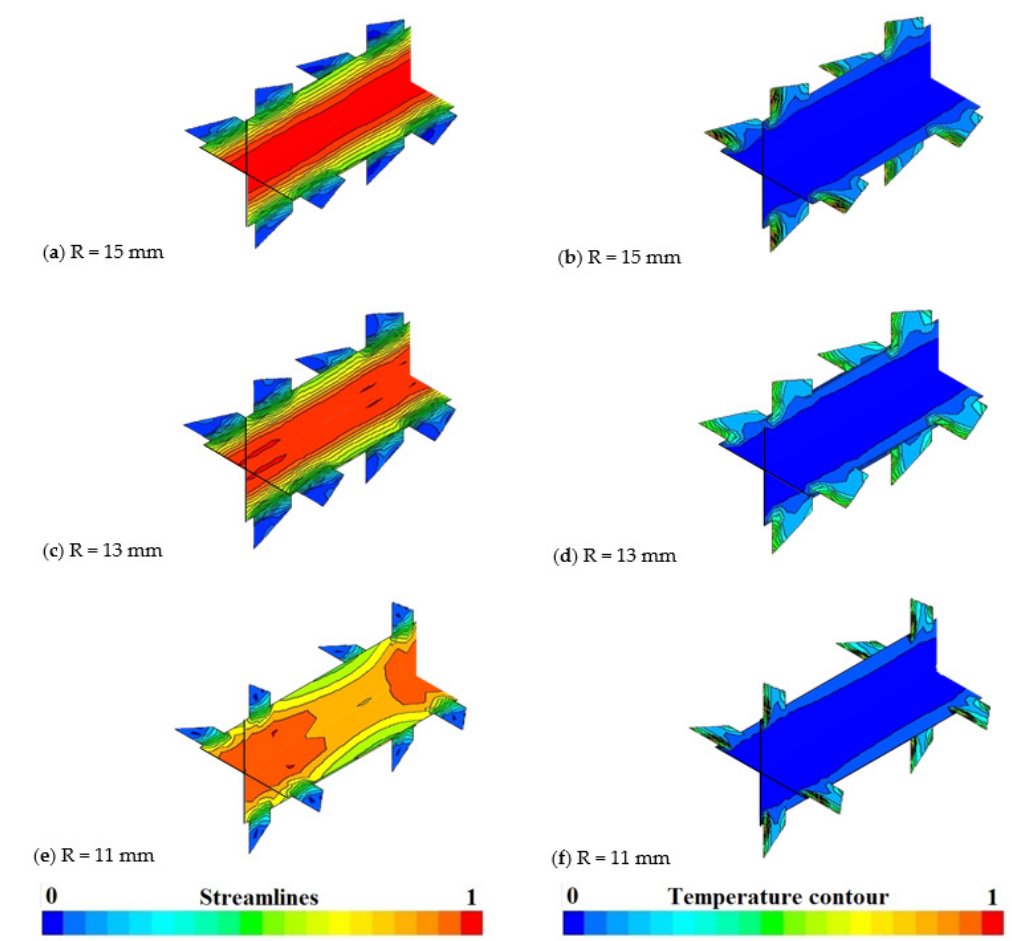
Figure 27. Streamlines and temperature contours for various configurations of Case E with different R parameters at E 2 = 24 mm, Re = 19,000, and ϕ =